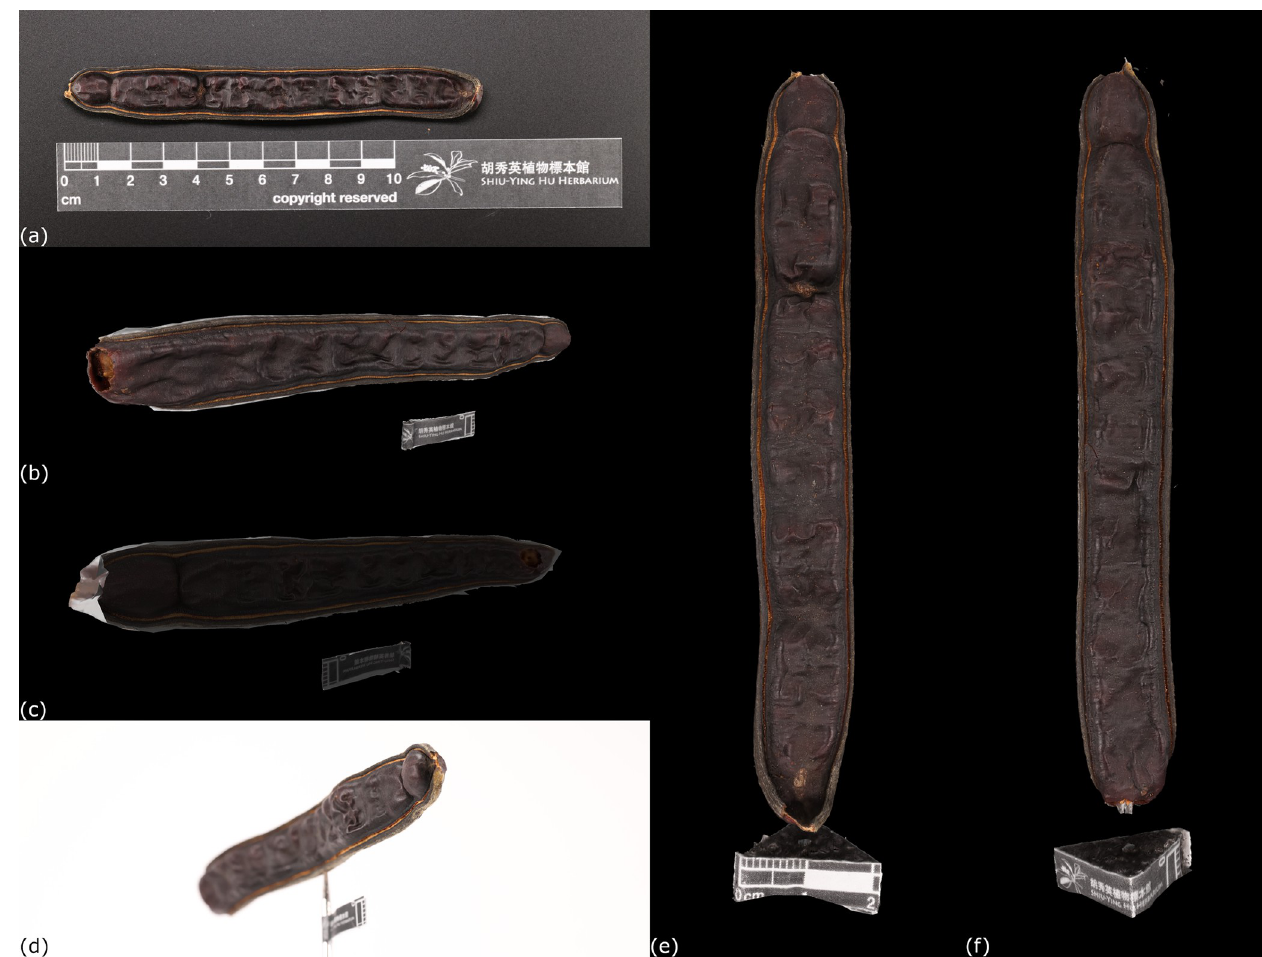
Fig 6. Comparison of 3D models of long dimension carpological material reconstructed by different positioning. (a) A carpological material of the fruit of Samanea saman (Jacquin) Merrill J. Wash (PH044). (b)&(c) The 3D model when PH044 was placed horizontally. The structure on the front side was reconstructed but the back side was not, as shown by the regions with darker color. (d) Decrease in sharpness of the images of PH044 was found due to greater depth of field from two ends, which reduced the coherence between images so the software could not recognize its structure for further reconstruction. (e)&(f) The 3D model when PH044 was placed vertically. The structure was reconstructed completely on both sides.